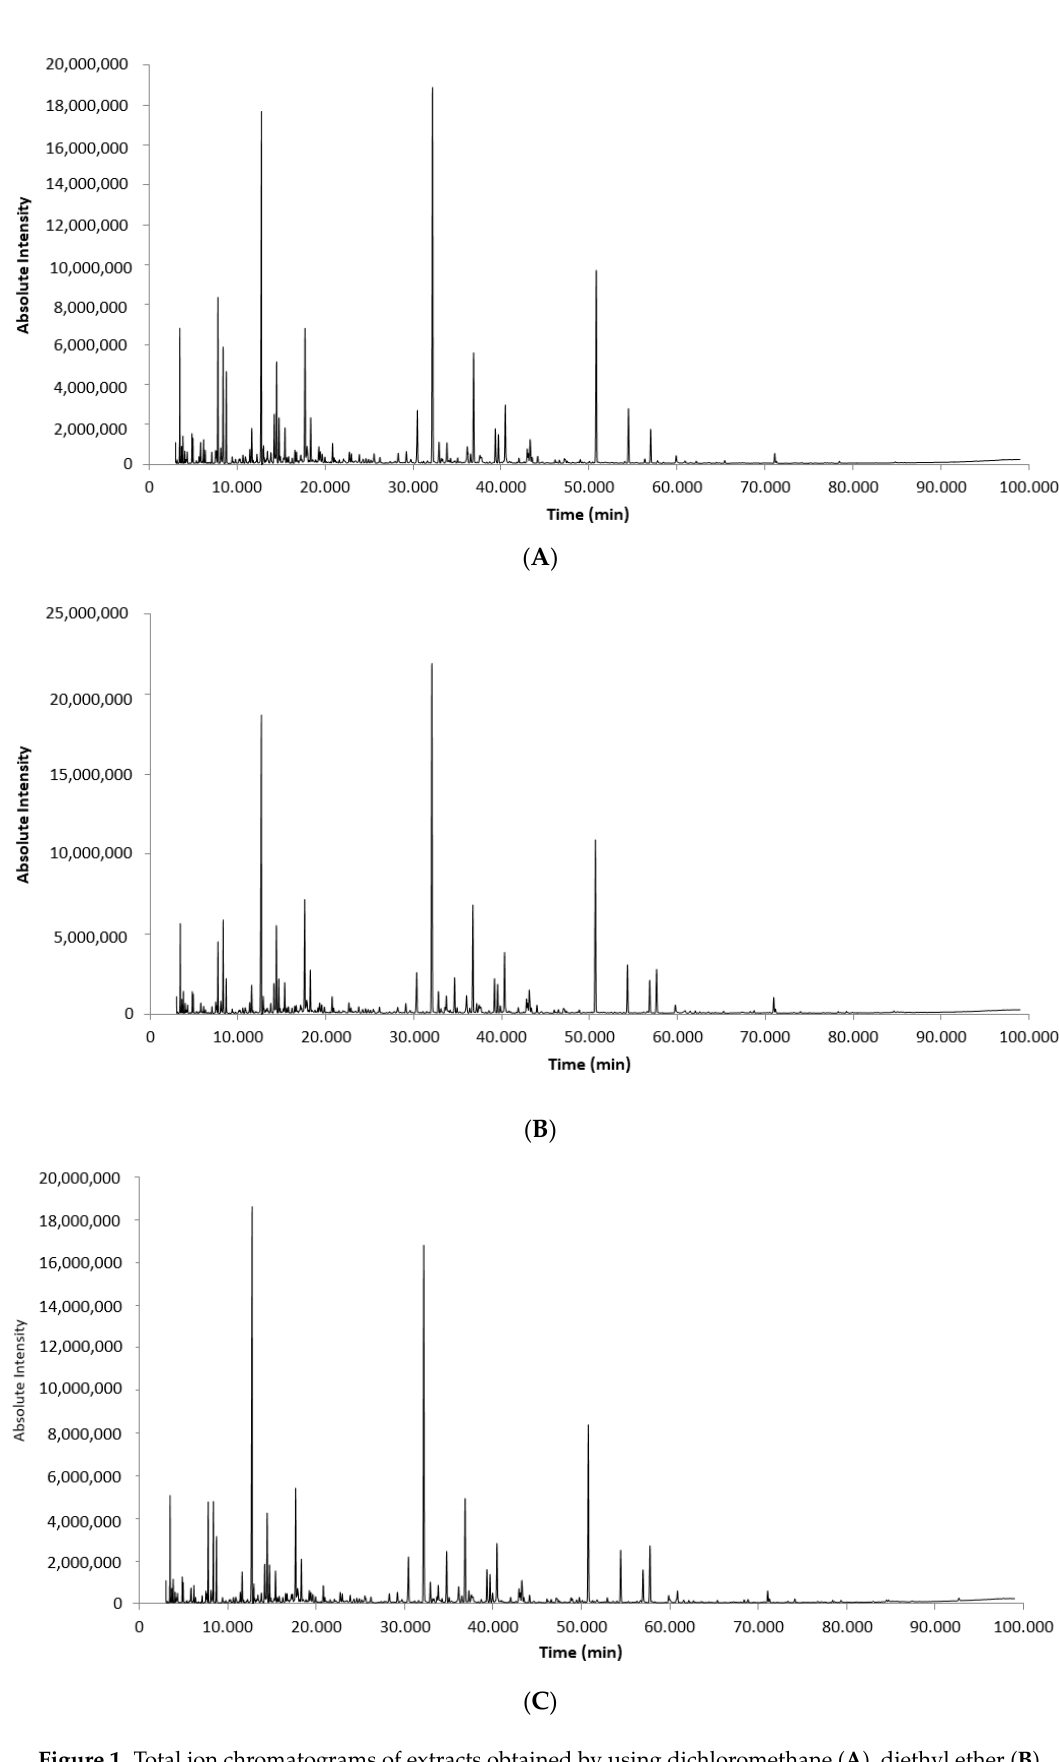
Figure 1. Total ion chromatograms of extracts obtained by using dichloromethane ( A ), diethyl ether ( B ) and ethyl acetate ( C ).